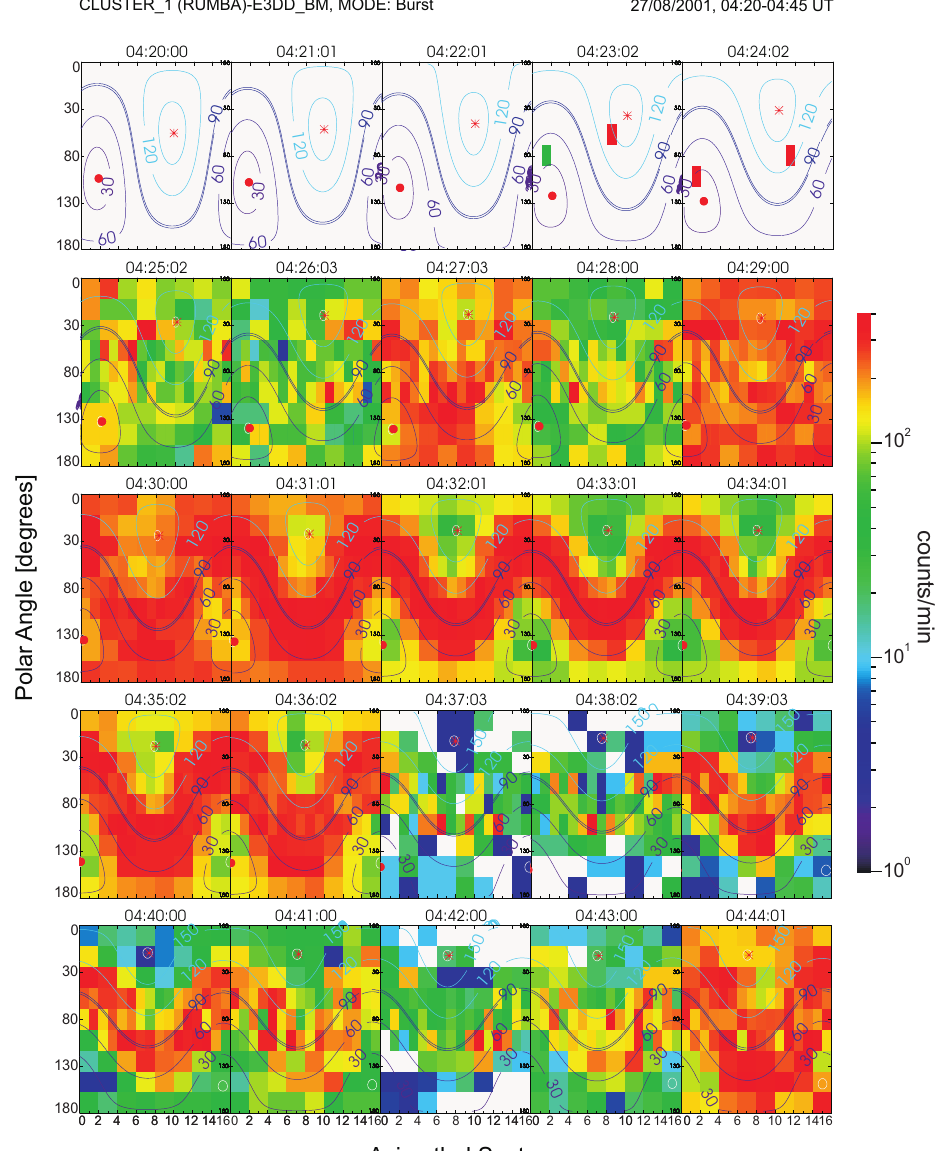
Fig. 6. Representative 3-D intensity distributions from S/C 1. Superimposed are the different pitch angle contours. Note the formation of field-aligned minima at ∼ 04:30 UT, which last for about 7min. The dot and the asterisk represent the points where the magnetic field vector intersects the unit